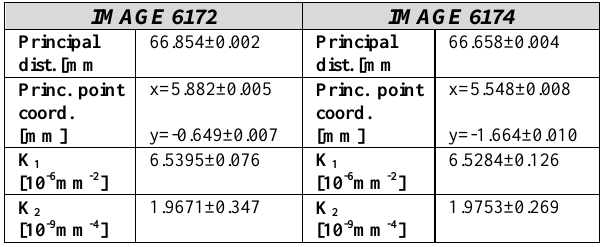
Table 1. Calibration parameters of the used images